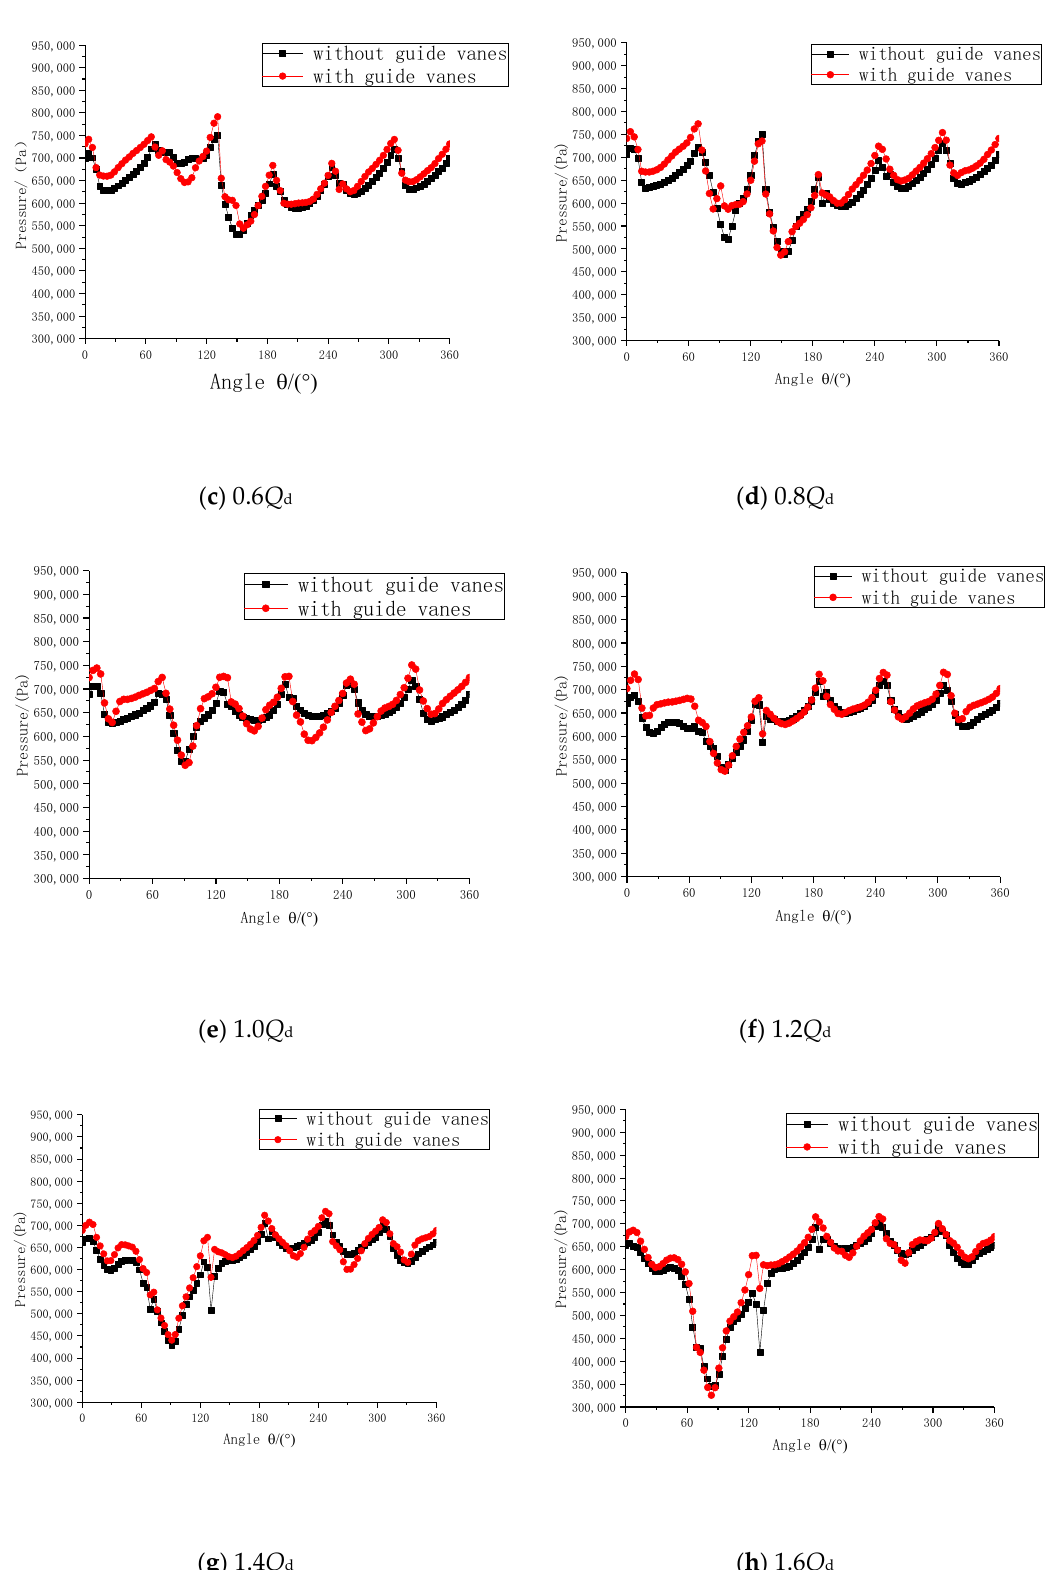
Figure 11. Pressure analysis of interface between volute and impeller.